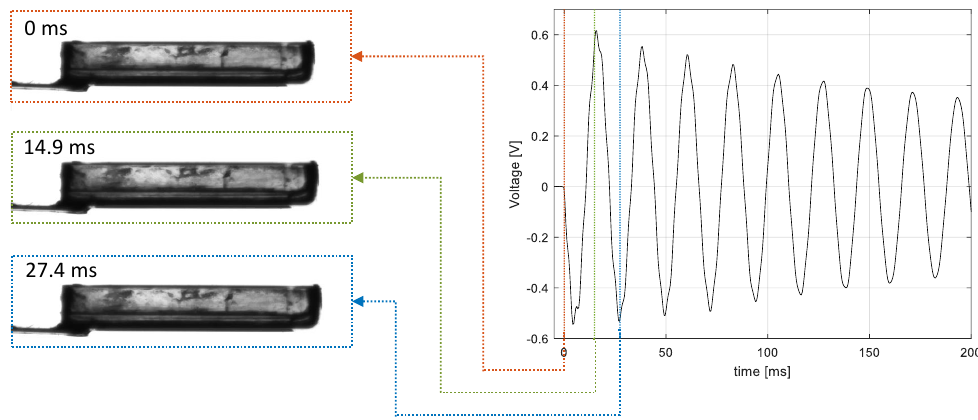
Figure 8. Drop impact on a dry spoon. The displacement due to the bending of the harvester is negligible with respect to the size of the spoon, even in the first vibration